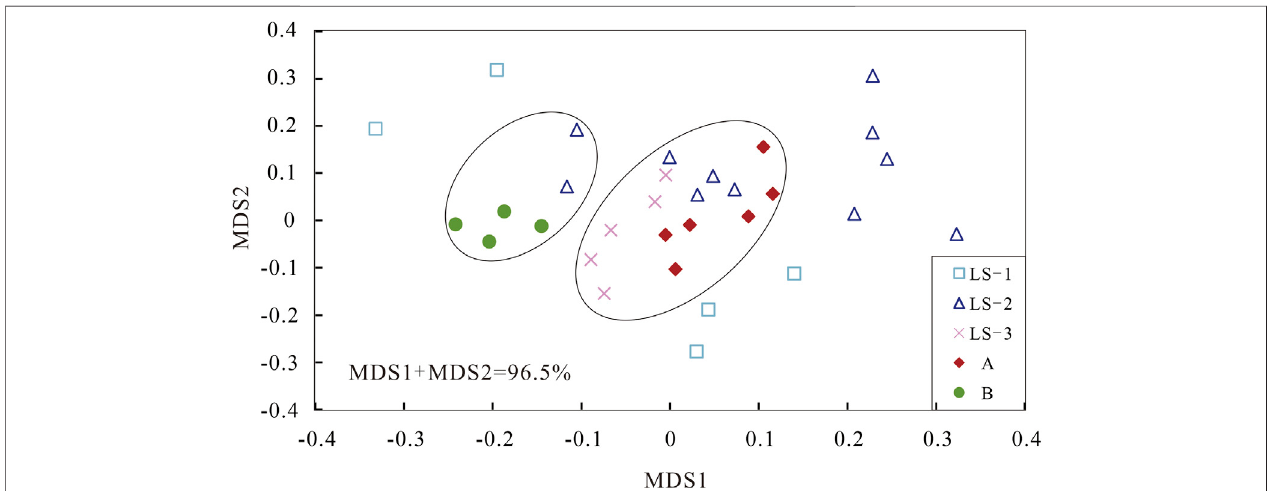
FIGURE 8 | Chemometric analysis of oil-source rock correlation for the Wushi Sag of the Beibu Gulf Basin based on multidimensional scaling (MDS). The fi rst two components of MDS, including MDS1 and MDS2, account for 96.5% of the total variance in the original dataset.